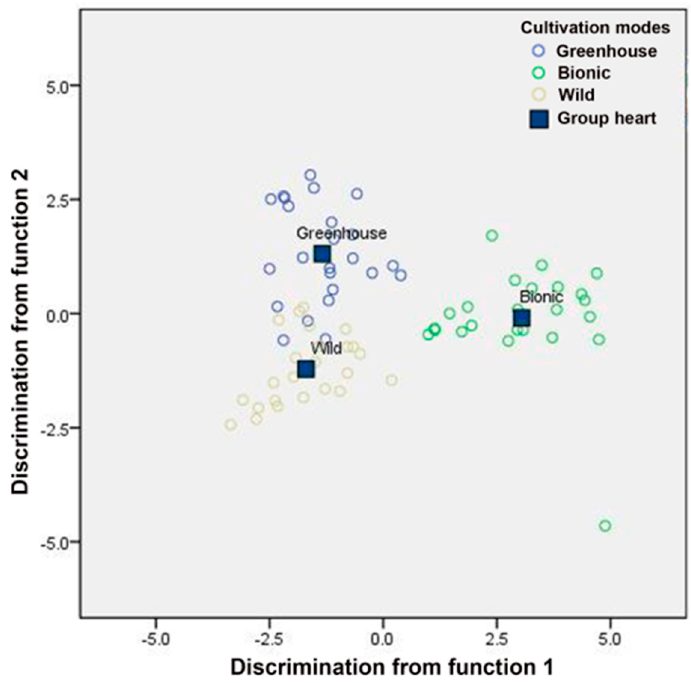
Figure 6. Linear discriminant analysis plot for different cultivation modes based on the climate factors. Purple circle indicates greenhouse cultivation mode; green circle indicates bionic cultivation mode; yellow circle indicates wild cultivation mode.